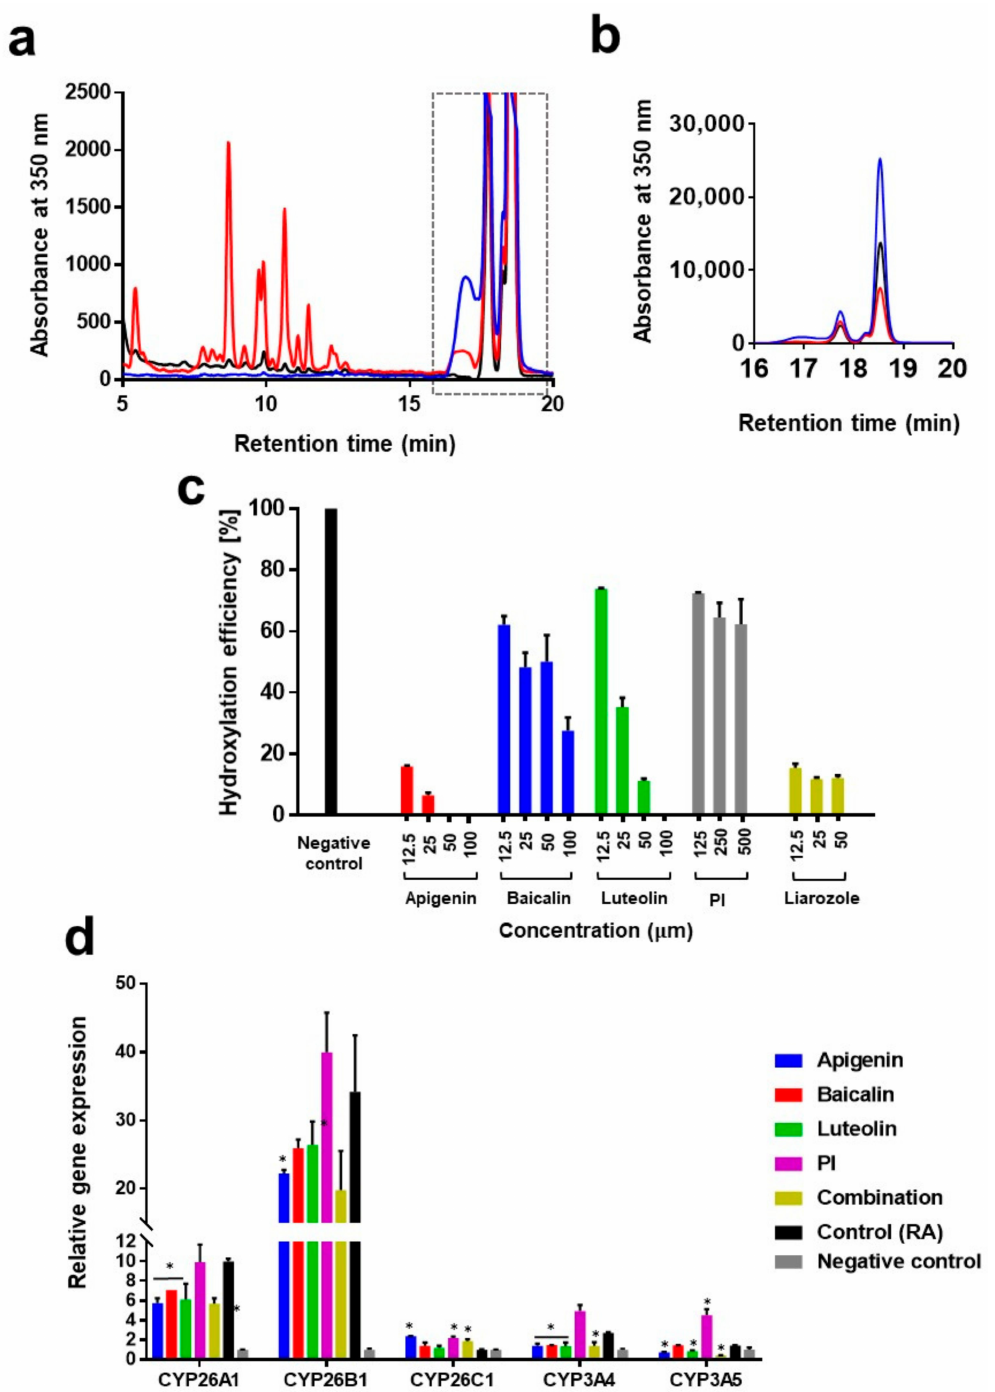
Figure 2. Screening RAMBA-mimicking compounds inhibiting RA hydroxylation. ( a ) HPLC spec- trum for RA metabolites. HaCaT were treated with 1 µ M RA for 48 h. Culture media and cell extracts were lyophilized and analyzed. For the inhibitor group (black line), 25 µ M of apigenin was used. ( b ) An enlarged detail of the spectrum surrounded by the dotted box in ( a ). ( c ) RA hydroxylation efficiency, calculated as follows: 100 × peak area (oxidized RA metabolites, 5~15 min)/peak area (oxidized RA metabolites + RA). PI refers to prolinamidoethyl imidazole. ( d ) Relative mRNA expres- sion of CYPs. HaCaT was cultured with candidates (25 µ M) and RA for 48 h. Combination refers to co-treatment of apigenin, baicalin, and luteolin (each 25 µ M). The bars denote the standard deviations. * Significantly different results (Student’s t -test, p <